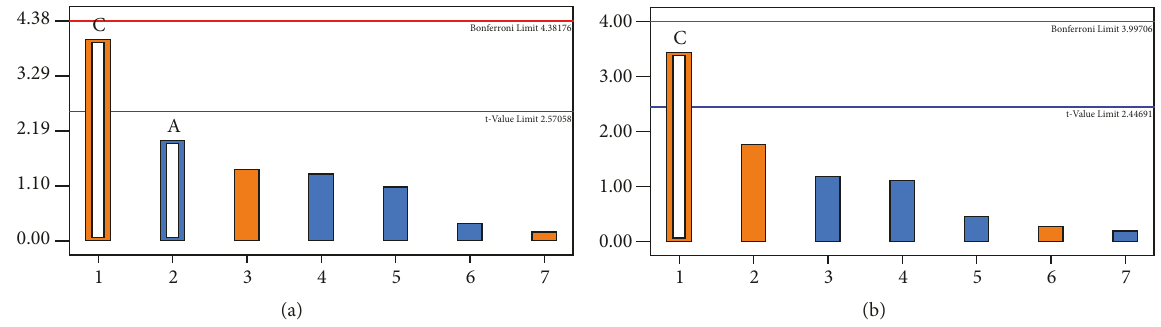
Figure 4: Pareto chart to evaluate the peaks area for Cd(II) (a) and Pb(II) (b), where C